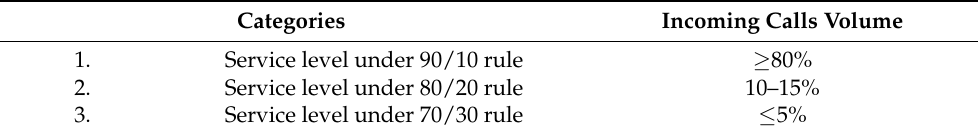
Table 3. Three categories of service level.